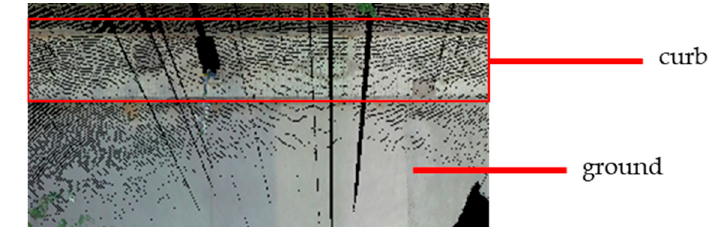
Figure 6. The similarity in color between ground and curb.